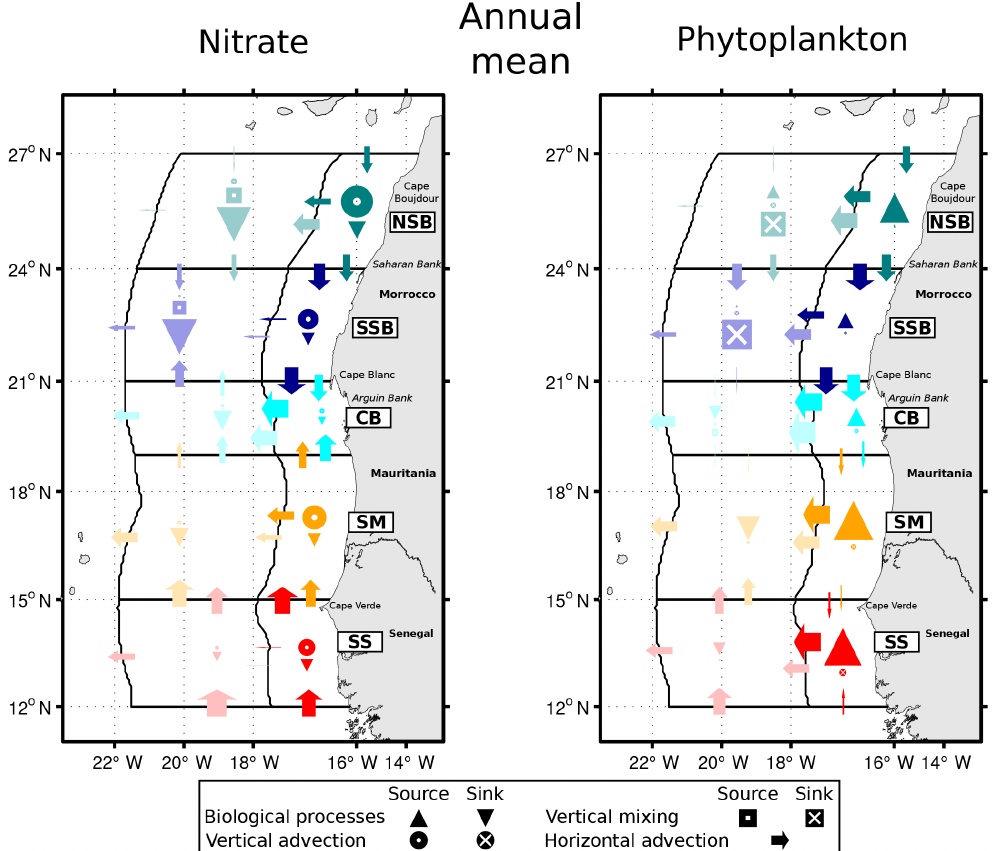
Figure 7. Schematic of the annual mean contribution of the different source and sink terms of nitrate and phytoplankton concentration within each box defined in this study. Each colour corresponds to a box (see legends in Fig. 2 for coastal and Fig. 8 for offshore boxes): northern Saharan Bank (NSB), southern Saharan Bank (SSB), Cape Blanc area (CB), Senegalo-Mauritanian region (SM) and southern Senegal region (SS). Arrows indicate horizontal advection, circles indicate vertical advection, squares indicate vertical mixing and triangles indicate biological processes. Within a circle or square, a white point indicates a source while a white cross indicates a sink; biological processes are a source (sink) if a triangle heads upward (downward). The size of arrows, circles, squares and triangles indicates the magnitude of the contribution of each source and/or sink term. For coastal boxes, the information is equivalent to that given in Fig.